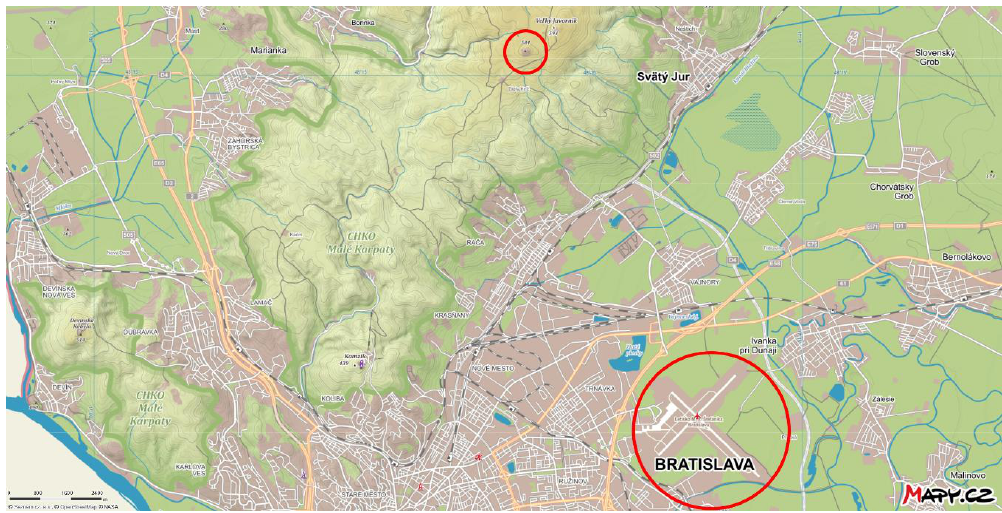
Figure 2. Bratislava Airport (big red circle) and Malý Javorník (the site with the radar of the Slovak Hydrometeorological Institute, small red circle) on the terrain map of the northern parts of Bratislava, including the Protected Landscape Area of the Little Carpathians (CHKO Malé Karpaty). Source: www.mapy.cz.